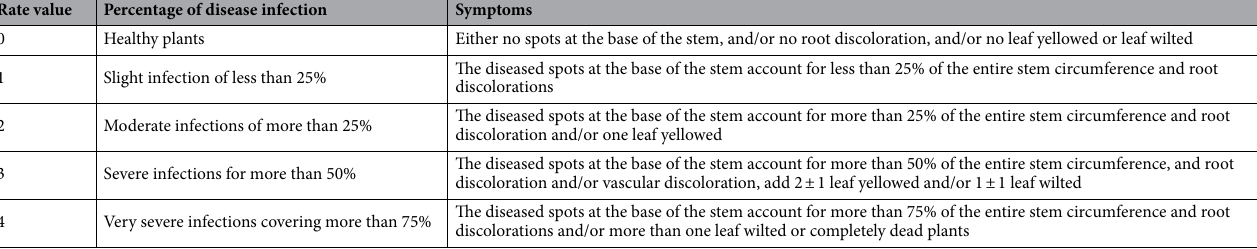
Table 1. The rate values for the percentages of disease